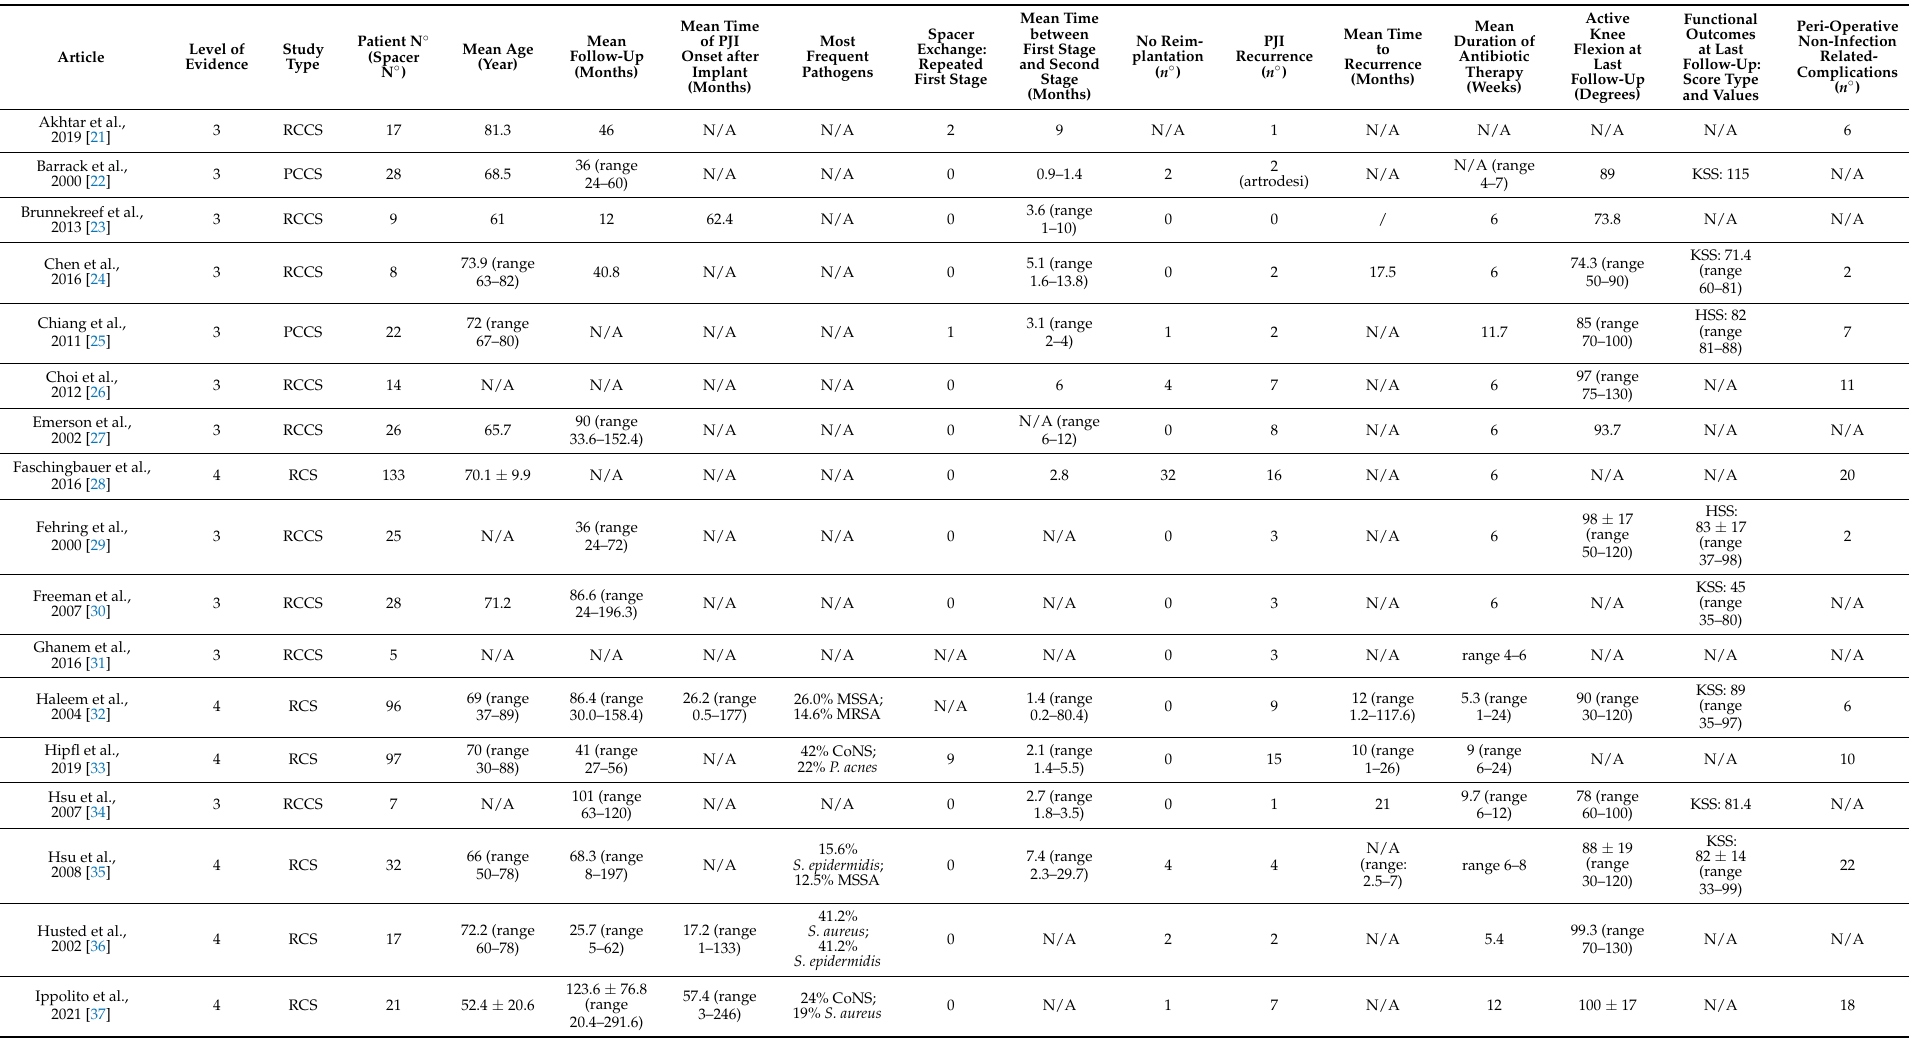
Table 1. Data from series reporting on static